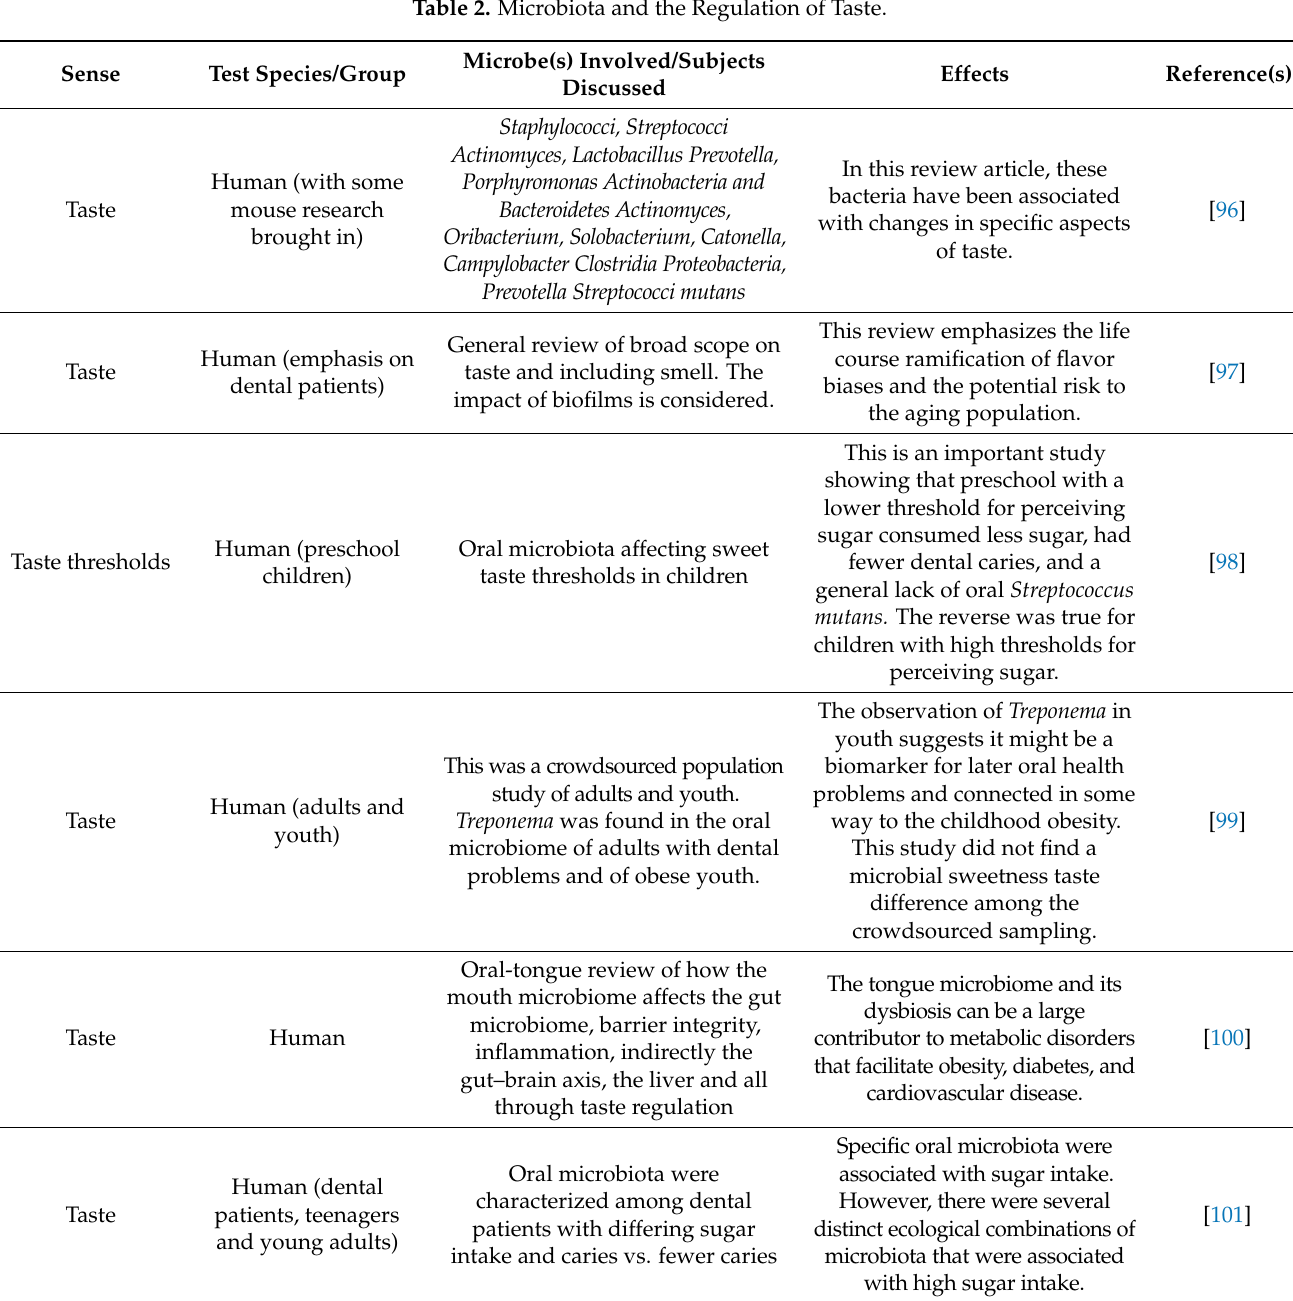
Table 2. Microbiota and the Regulation of